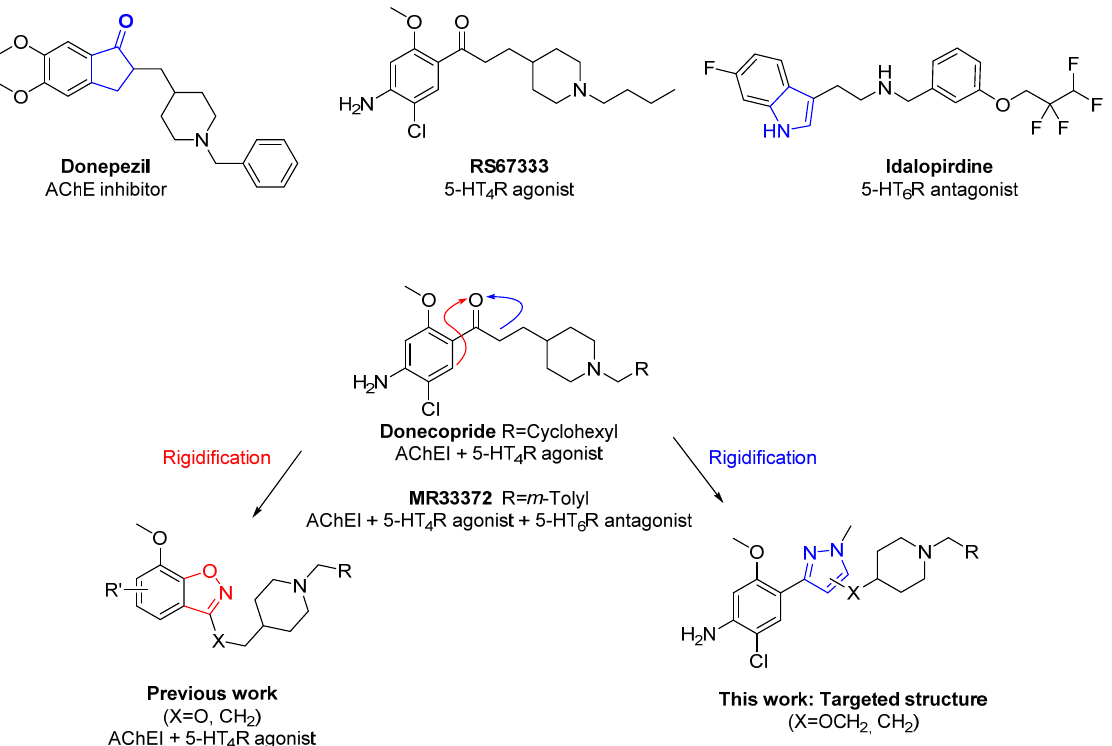
Figure 1. Structures of reference ligands and MTDL (Donecopride, MR33372, benzisoxazole) and targeted structure.